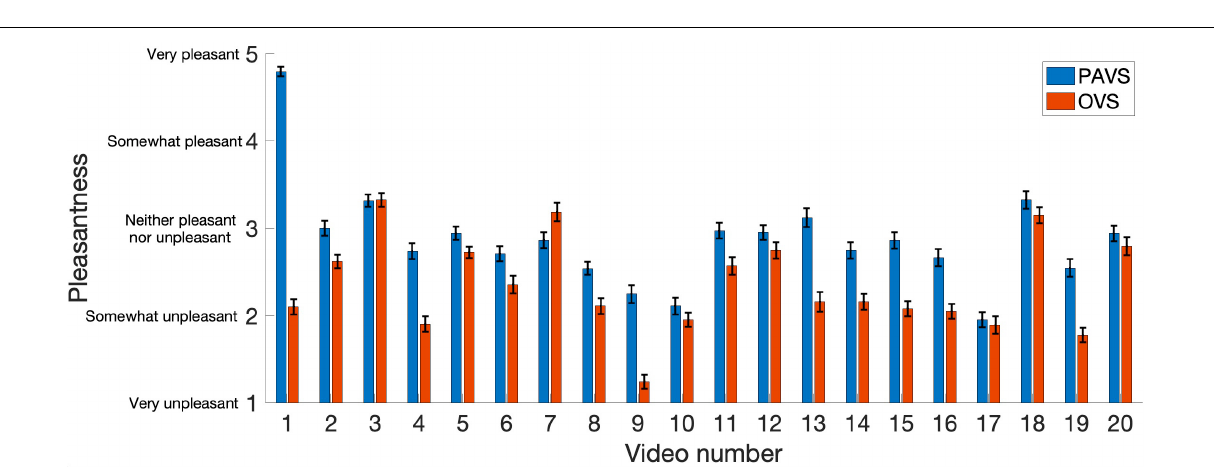
FIGURE 2 | Mean ratings of the 40 stimuli in Study 3 for audio-visual match (x-axis) and pleasantness (y-axis), averaged across 102 observers. Blue dots show PAVS stimuli and red dots show OVS stimuli. Line segments connect the corresponding PAVS and OVS stimuli.